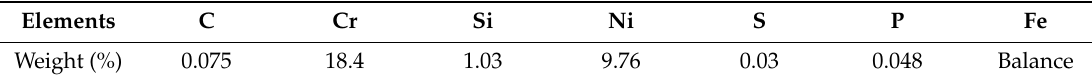
Figure 1. Experimental setup. Table 1. Chemical composition of stainless steel